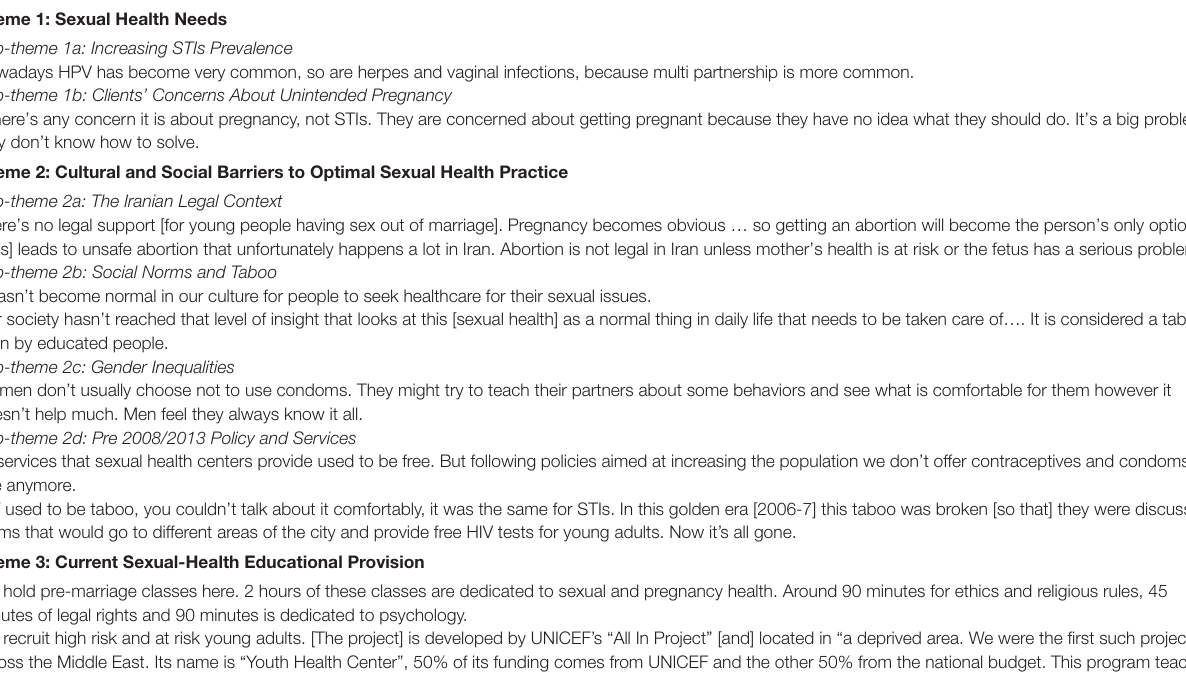
TABLE 2 | Illustrative quotes by Theme and